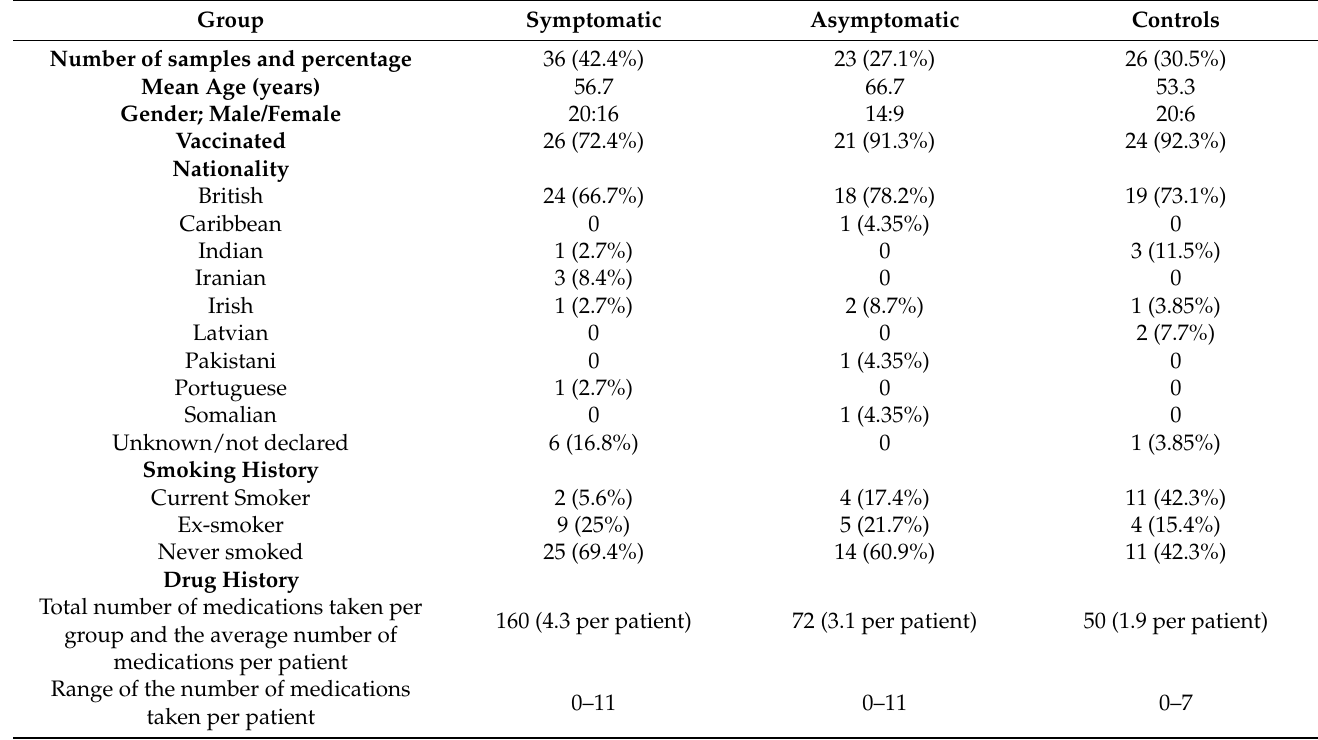
Table 1. Demographic data for subject